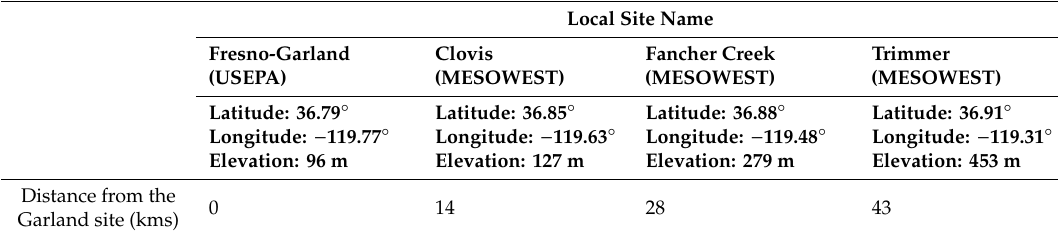
Table 2. Distance to meteorological sites from the Garland